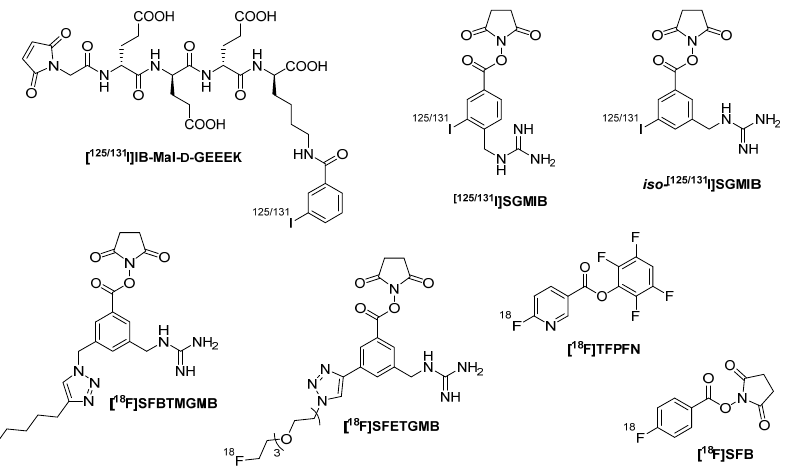
Figure 4. Radiohalogenated prosthetic groups which have been applied to nanobodies in a single final conjugation reaction.